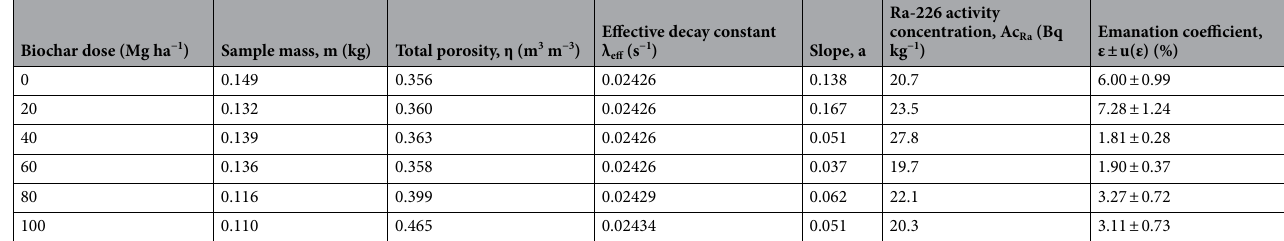
Table 2. Parameters values used for calculation a emanation coefficient incorporating Eqs. (2–5) and the obtained values of ε with the total uncertainty u(ε).